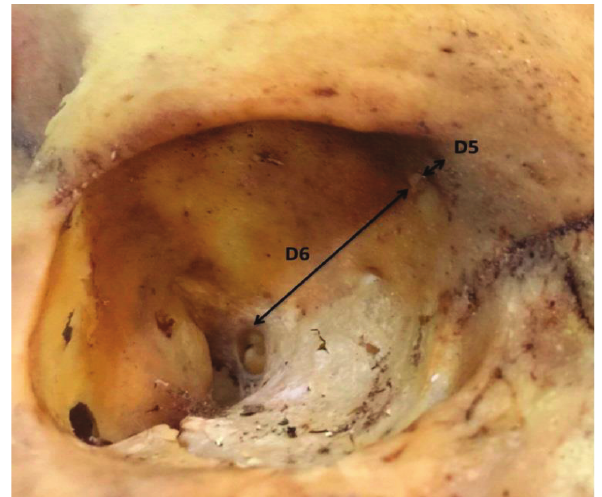
Fig-3: D5 is shown along the sagittal plane from the anterior orbital opening and trochlear fovea or spine. D6 represents the distance of spine or fovea from the optic